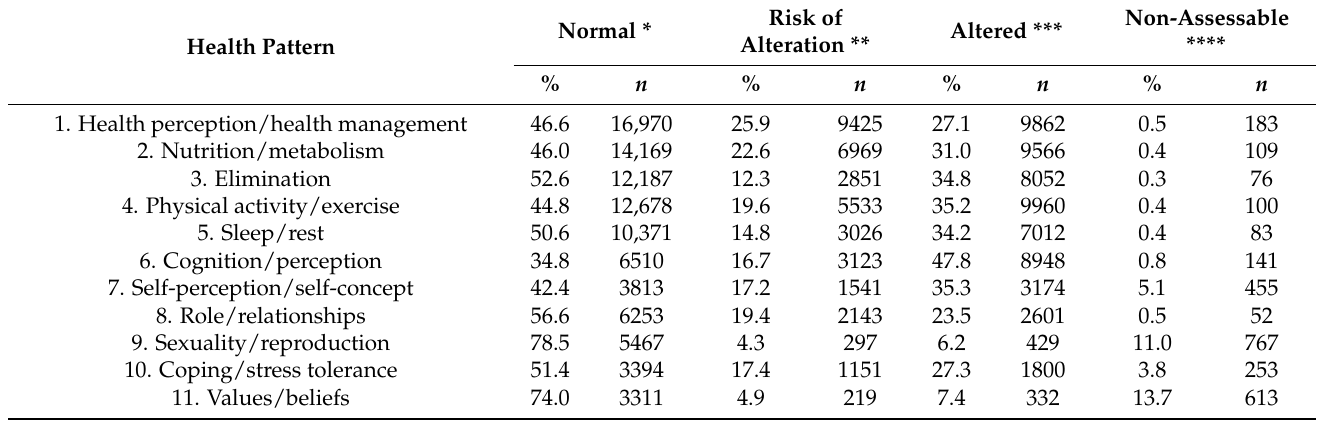
Table 2. Functional status of the HCCP population according to outcomes of assessment by health pattern.